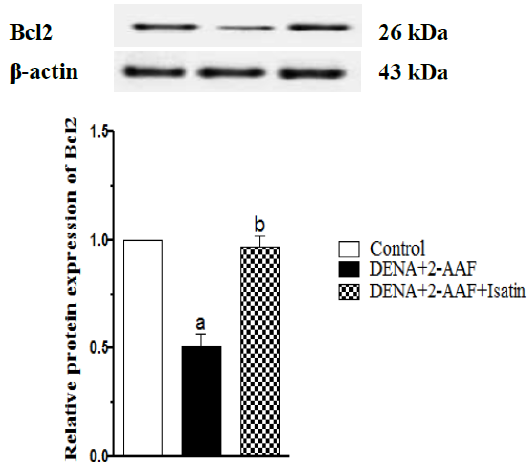
Figure 7. Isatin reversed the DENA/2-AAF-induced downregulation of hepatic Bcl2 protein expres- sion. A typical Western blot is shown (upper panel). Data are presented as mean ± SEM. a p < 0.05 vs. control group. b p < 0.05 vs. DENA/2-AAF group.